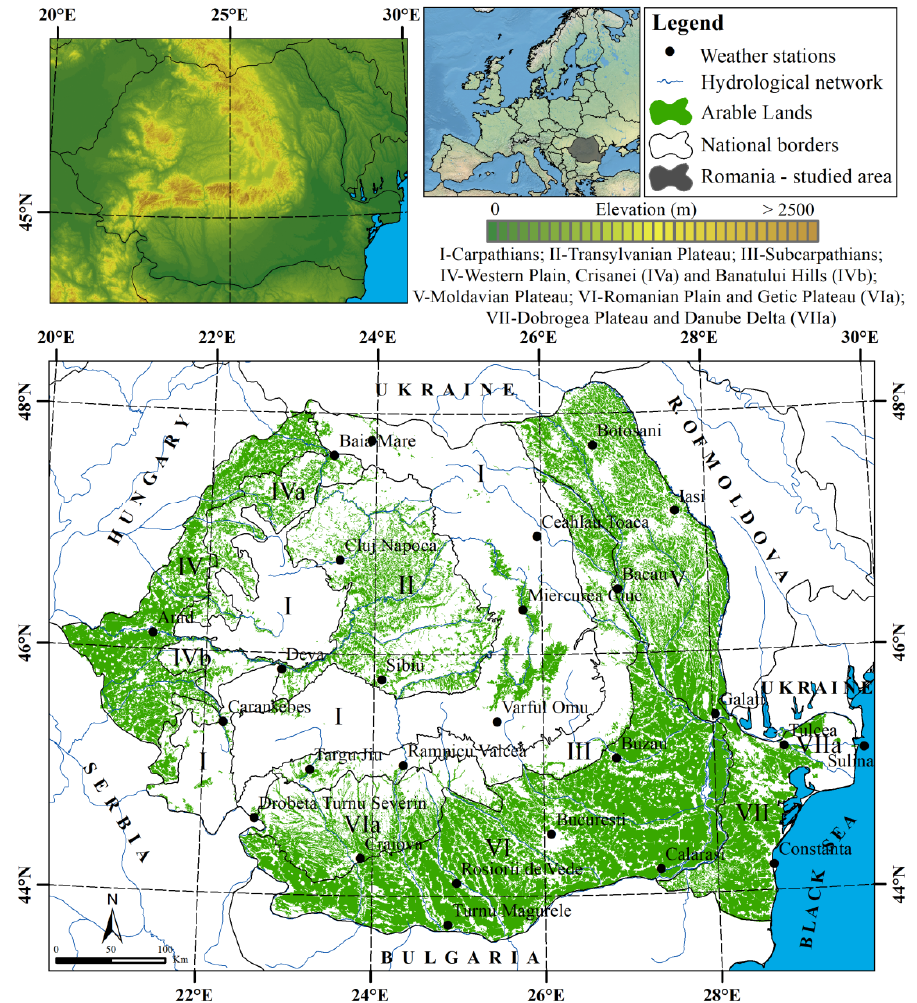
Figure 1. Geographical position of Romania and the extension of arable lands (source: Corine Land Cover (CLC) 2018).